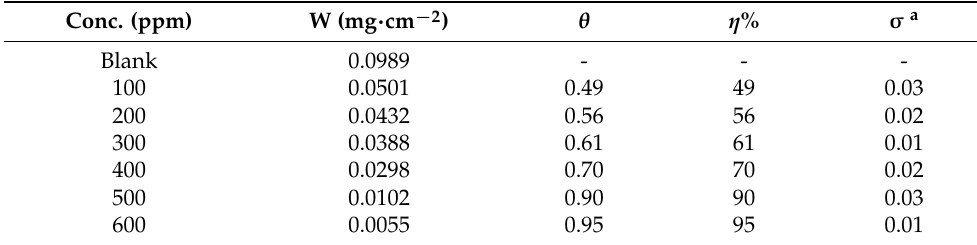
Table 1. % IE for various concentrations (Conc.) of the C. tagal extracts for corrosion of mild steel in 1 M HCl obtained by weight loss measurements at room temperature (303 ± 1 K).